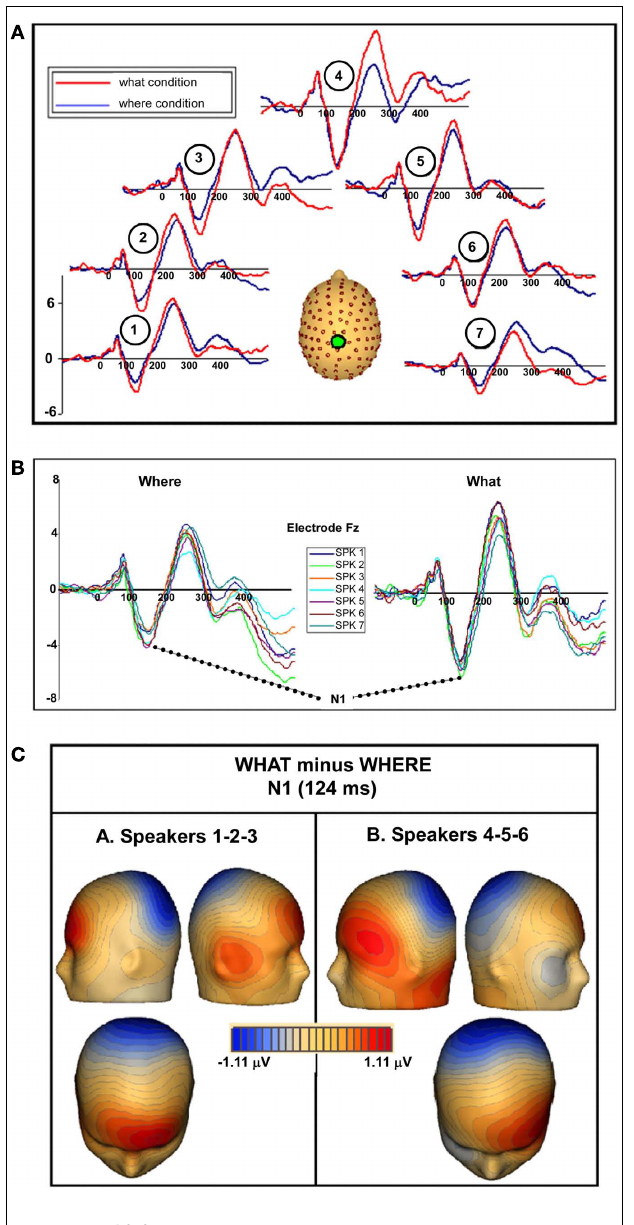
FIGURE 10 | (A) WHAT (red) and WHERE (blue) group-averaged waveforms taken from electrode Cz are shown for seven individual sound source averages. In the figure, each waveform pair is shown at a location consistent with the sound source from which it was derived. (B) Separate waveforms for each of the sound sources are overlaid from each condition at one representative electrode (Fz). (C) Topographic maps of the N1 difference between conditions ( WHAT minus WHERE ) showing distinct topographies for sound sources on the left (Sound sources 1–2–3) compared to the right (Sound sources 5–6–7).